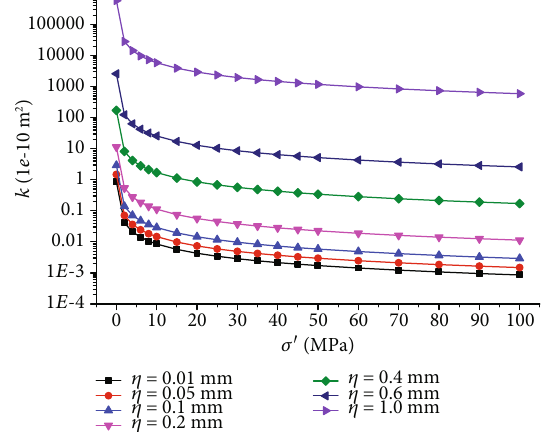
Figure 19: Permeability vs. e ff ective stress under di ff erent mean aperture size η